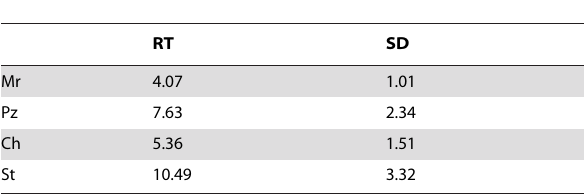
Table 3. The mean response time for each